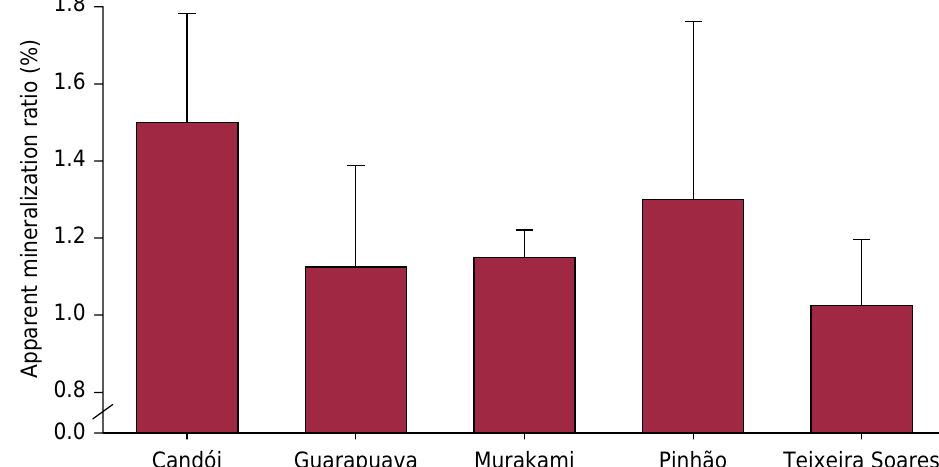
Figure 4. Apparent mineralization ratio of N from soil organic matter at five sites in the South- Central region of Paraná. Vertical bars indicate mean standard errors.